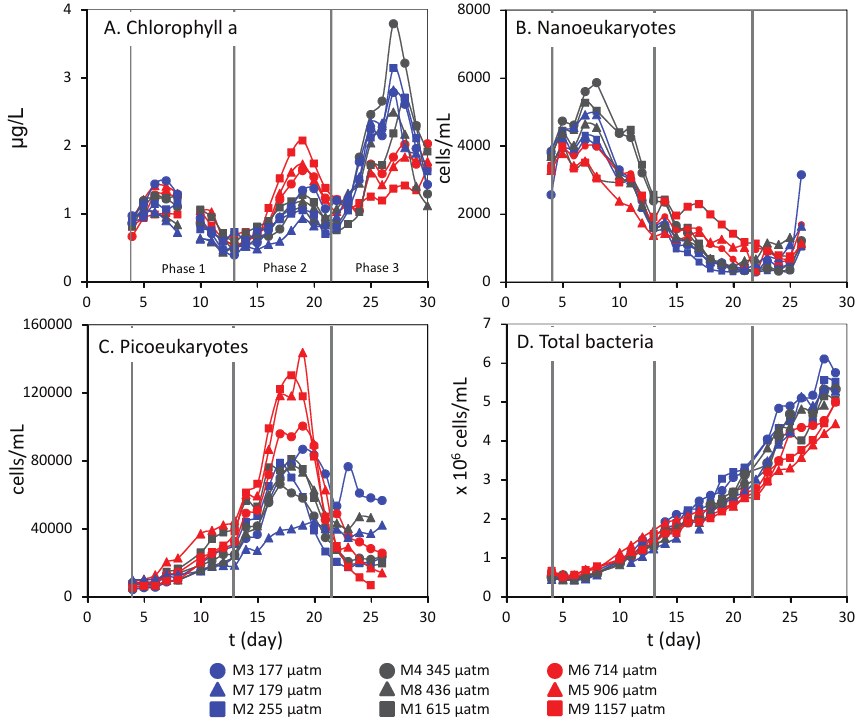
Fig. 1. Concentrations of chlorophyll a (µgL − 1 ) (A) , nanoeukaryote (B) and picoeukaryote abundances (C) (cellsmL − 1 ) and total bacteria (D) ( × 10 6 cellsmL − 1 ) over the course of the experiment. Experimental phases are as follows: PI t 4 – t 12 , PII Days t 13 – t 21 , PIII Days t 22 – t 30 . p CO 2 (µatm) shown in the legend are averages for period of halocarbon sampling ( t 8 – t 27 )